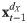
Spurious information transfer resulting from under-embedding (modified from [22]).(A) Actual coupling between processes X and Y. (B) Mutual information between the present value in X, xt, and a value in the far past of X, xt−(τ⋅d), conditional on all intermediate values xt-1dX (shaded box), the mutual information is non-zero, i.e., xt−(τ⋅d) holds some information about xt. (C) Both directions of interaction are analyzed; (D) Information in xt−(τ⋅d) (white sample point) is transferred to Y (solid arrow), because of the actual coupling X → Y. The information in xt−(τ⋅d) about xt is thus transferred to the past of Y, yt-udY, which thus becomes predictive of xt as well. Assume now, we analyzed information transfer from Y to X, I(xt:yt-udY|xt-1dX), without a proper embedding of X, xt-1dX: Because of the actually transferred information from xt−(τ⋅d) to yt-udY, the mutual information I(xt:xt-1dX) is non-zero. If we now under-embed X, such that the information in xt−(τ⋅d) is not contained in xt-udX and is not conditioned out, I(xt:yt-1dY|xt-udX) will be non-zero as well. In this case, under-embedding of the target X will lead to the detection of spurious information transfer in the non-coupled direction Y → X. (E) Information transfer is falsely detected for both directions of interaction, the link from Y to X is spurious (dashed arrow).